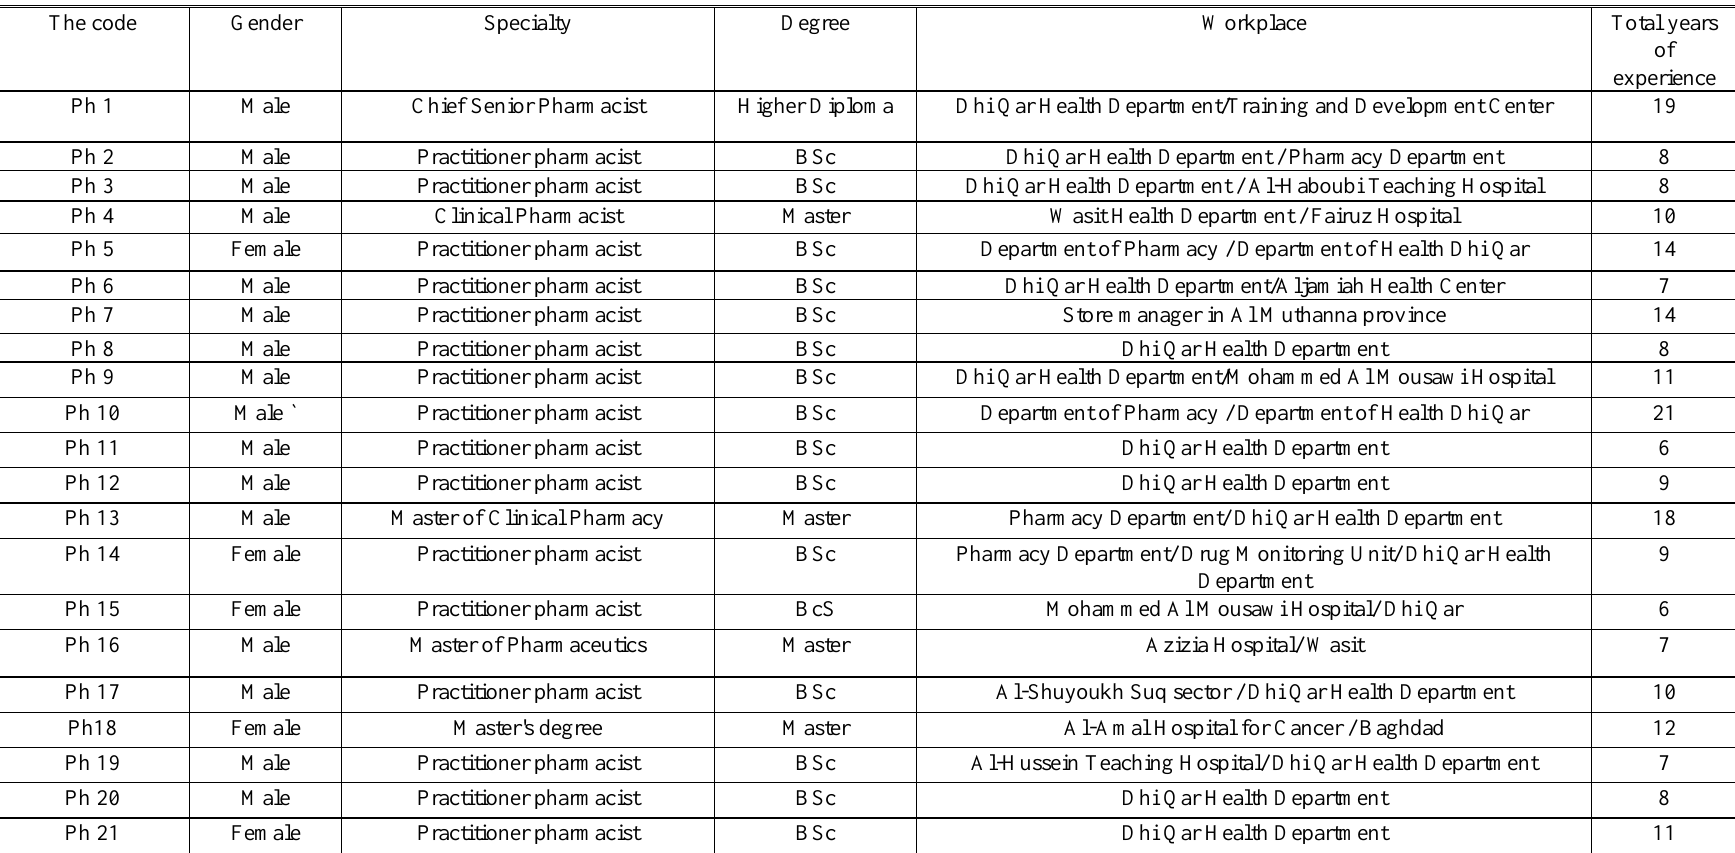
Table 1. Demographics characteristics of the participating pharmacists The